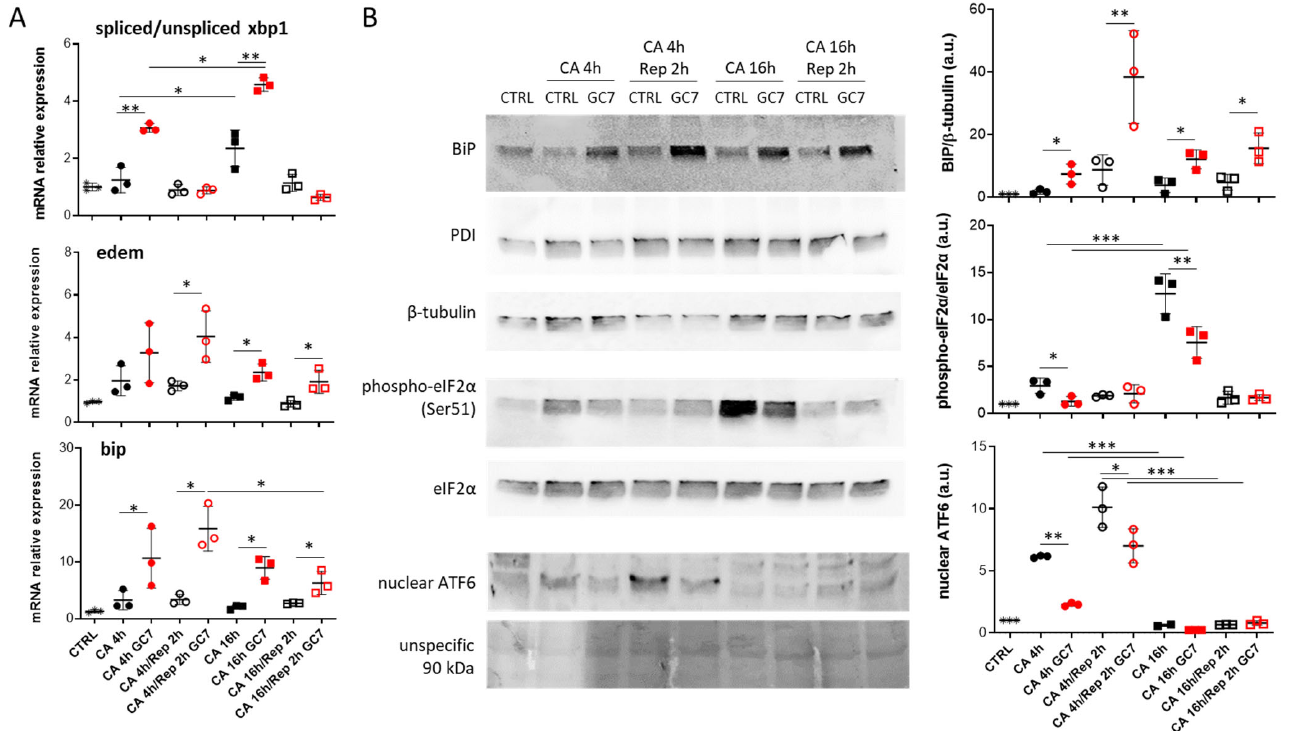
Figure 4. GC7 modulates ER stress response induced by cold anoxia and normothermic reoxygenation. PCT cells pretreated for 8 h either with a vehicle or with 30 µ M GC7 and 24 hours later, exposed to either cold anoxia (CA, ≤ 0.1% O 2 , 4 °C) for 4 or 16 h and followed or not by normothermic reoxygenation (“Rep”, 37 ◦ C) for 2 h. At the end of the experiment cells were either lysed for ( A ) mRNA or ( B ) protein expression analysis. ( A ) Scatter plot representation of individual values along with mean ± SD (n = 3) for the ratio of spliced/unspliced xbp1 mRNA and the relative expressions of edem and bip . ( B ) Representative western blots of BiP, β -tubulin, PDI, eIF2 α (total and phosphorylated on Ser51 site) and ATF6 protein levels and the scatter plot representation of normalized individual along with mean ± SD, n = 3. * = p ≤ 0.01; ** = p ≤ 0.001; *** = p ≤